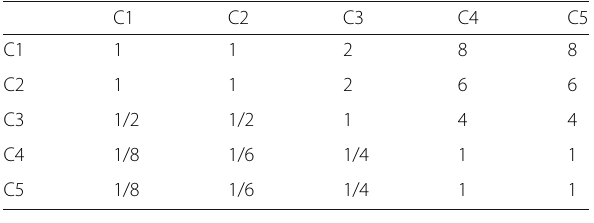
Table 11 The judgement matrix under “ Service Capability ” .